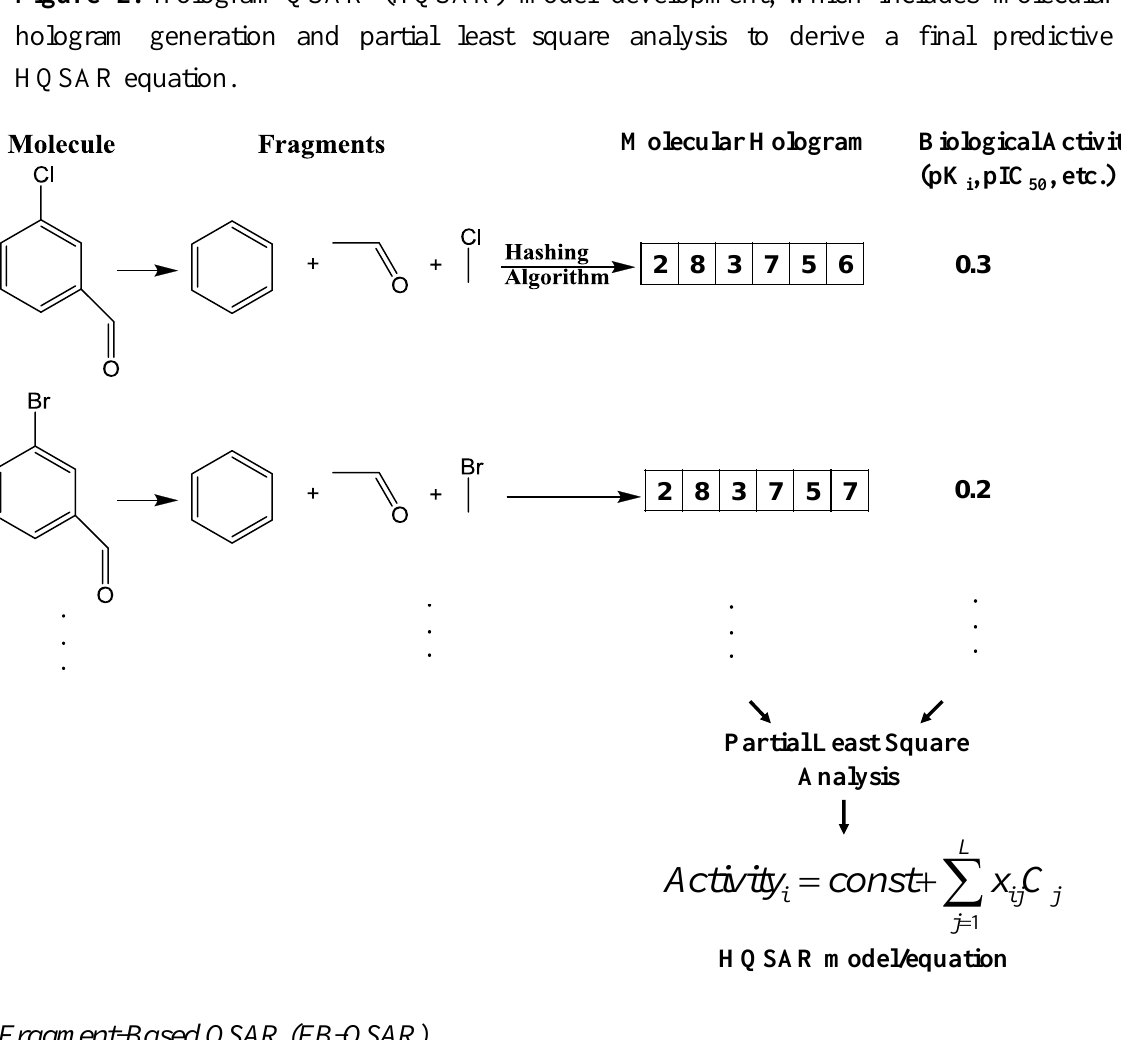
Molecular Hologram Biological Activity (pK , pIC , etc.) i 50